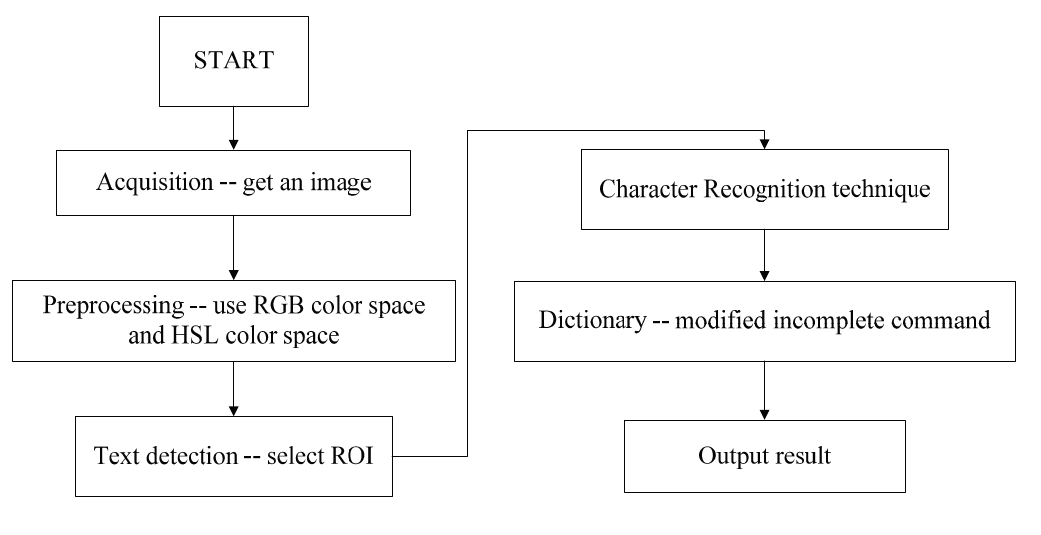
Figure 7. Image recognition